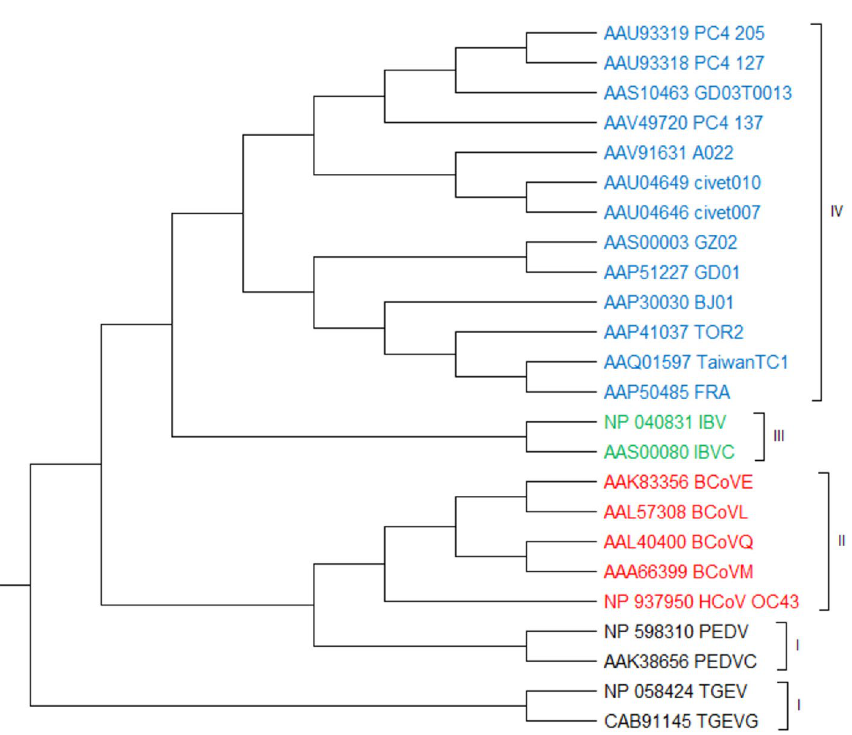
Figure 10. 24 Coronavirus protein sequences constructed by our method